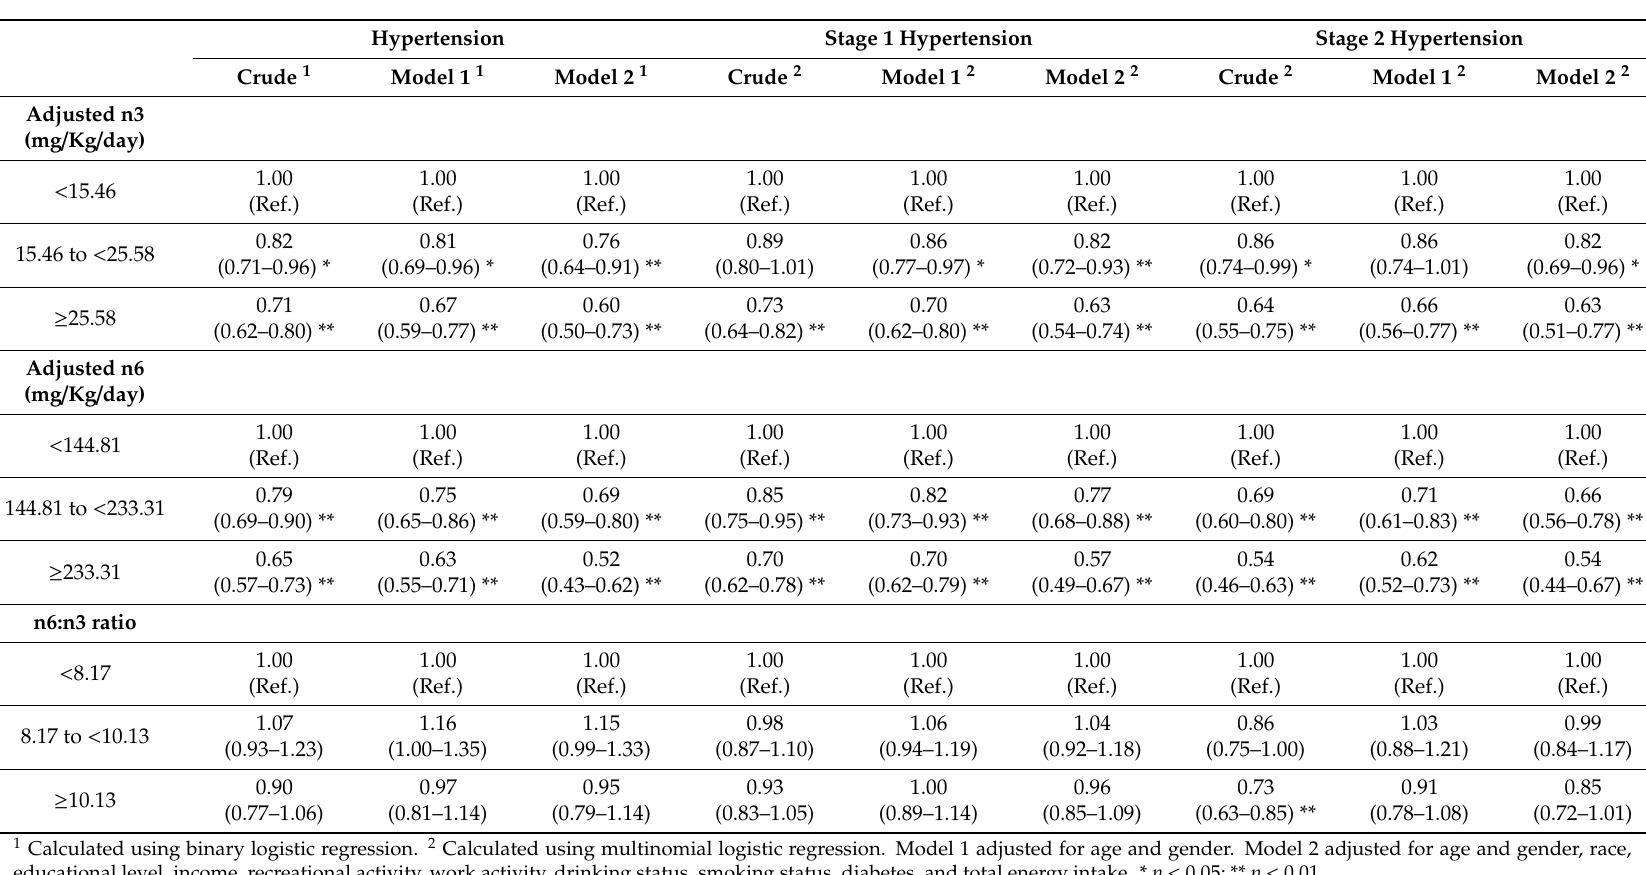
Table 4. Weighted odds ratios (95% confidence intervals) of newly diagnosed hypertension across tertiles of adjusted dietary n3, n6 fatty acids intake and n6:n3 ratio, NHANES 2007–2014 ( N =